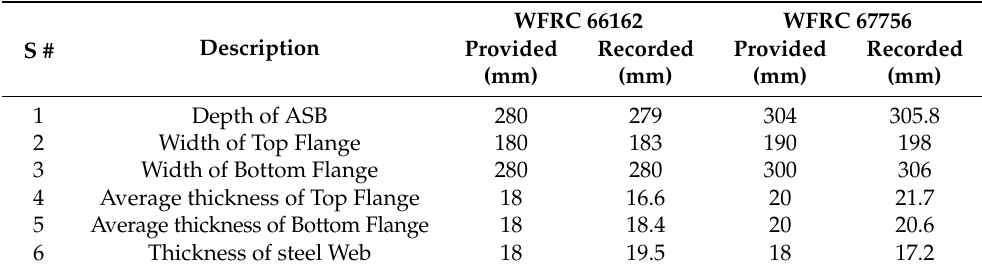
Figure 1 . The Tested Specimen WFRC 66162, ( a ) Elevation; ( b ): Loading conditions; ( c ) Section at AA’; ( d ) Section at BB’ . AA’; ( d ) Section at BB’. Table 1. Geometric properties of steel sections, WFRC